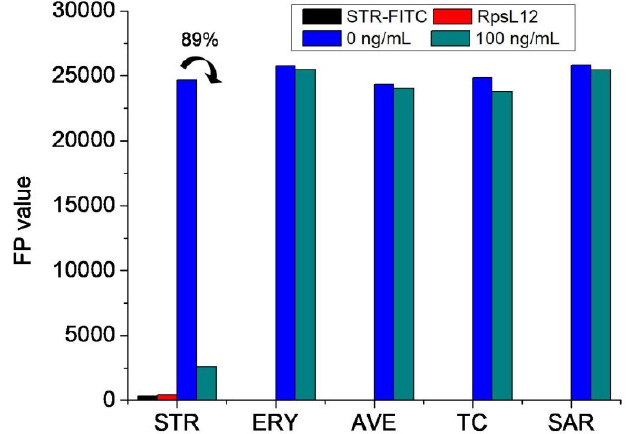
Figure 5. FP values when testing STR and other drugs by using STR-FITC (8 µ g/mL) and RpsL 12 (2 µ g/mL) (pH 7.0; incubation time 5 min; ERY = erythromycin, AVE = avermectin, TC = tetracycline, SAR = sarafloxacin).